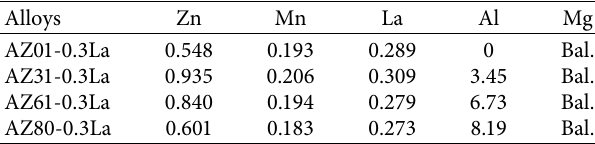
Figure 1: Diagram of the technological process of the as-extruded studied alloy. Table 1: Actual composition of the materials (wt.